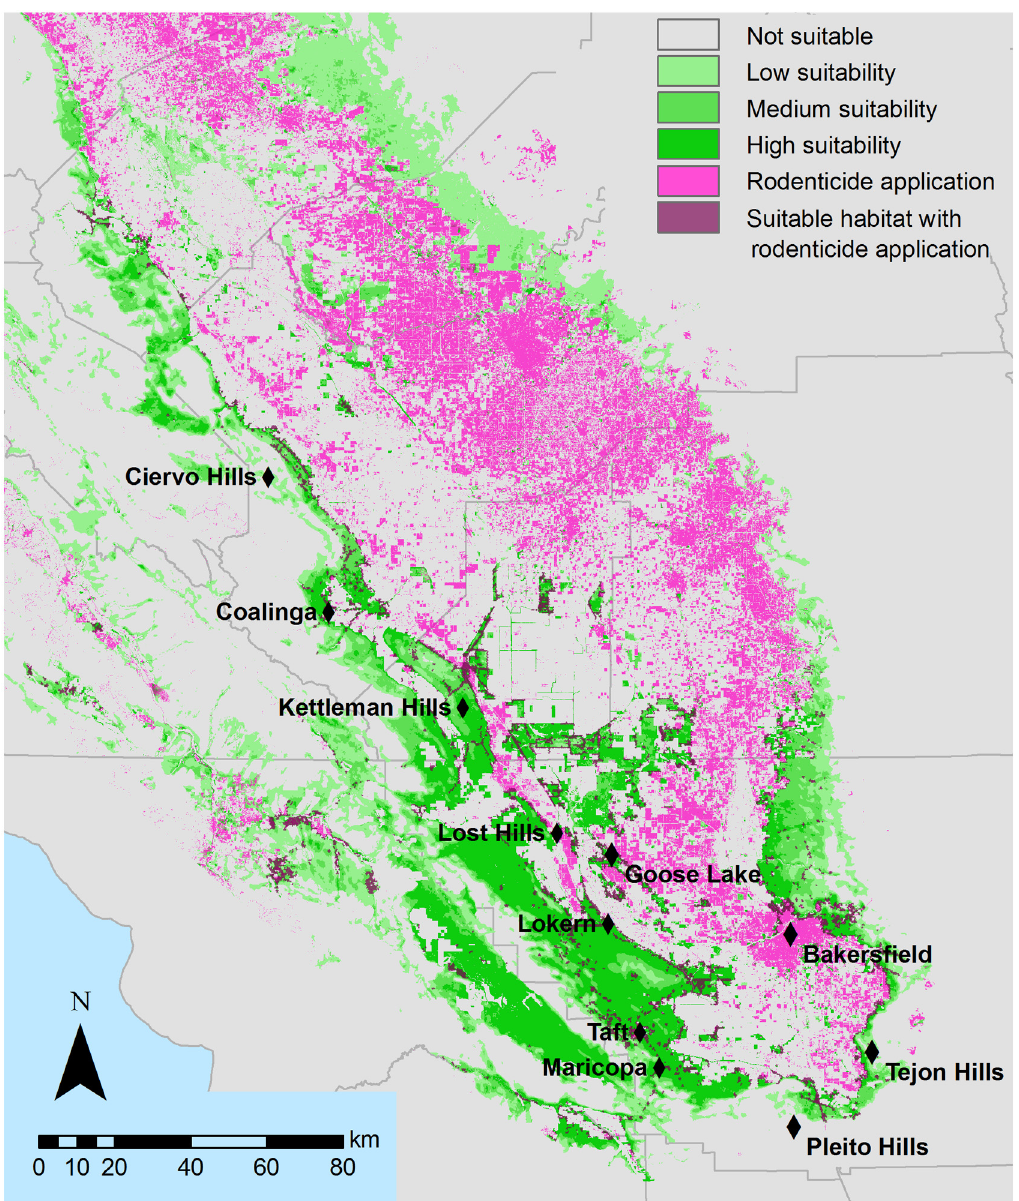
Fig 1. Habitat suitability and rodenticide use. San Joaquin kit fox suitable habitat (green) and rodenticide use within the kit fox range (purple). Rodenticide use is defined as 30 x 30 m pixels which included land use where rodenticides are commonly used. Not suitable is defined as suitability = 0, low suitability is 2 – 4, medium suitability is 4 – 6.5, and high suitability is 6.5 – 8. Habitat suitability is from [26] and rodenticide use was defined as described in the methods. The map was created in ArcMap 10.2.